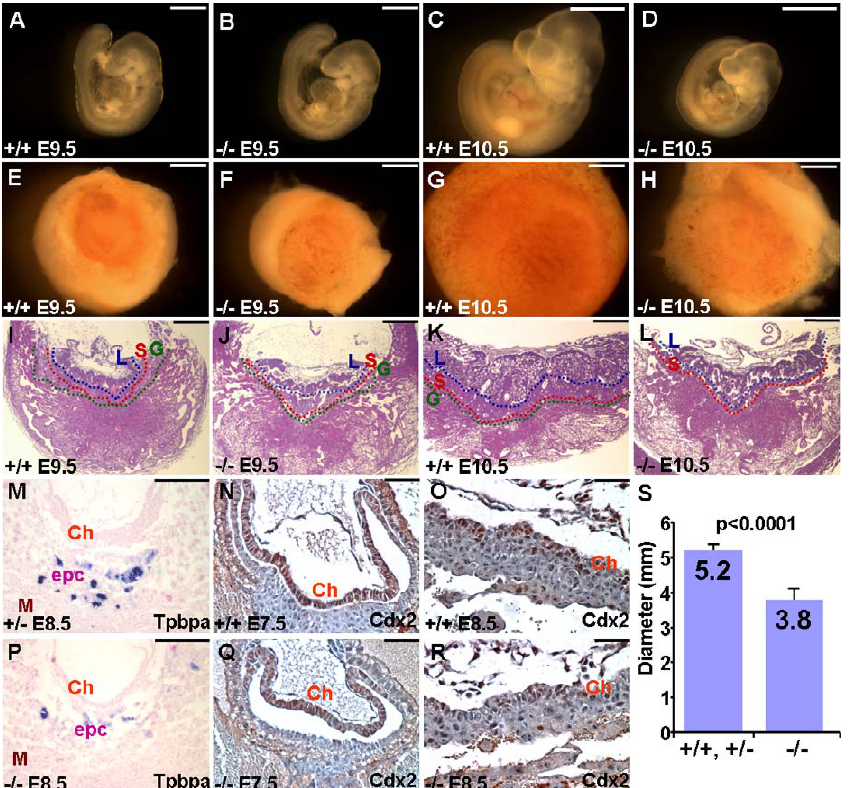
Figure 2. Embryonic and Extraembryonic Abnormalities Caused by SENP2